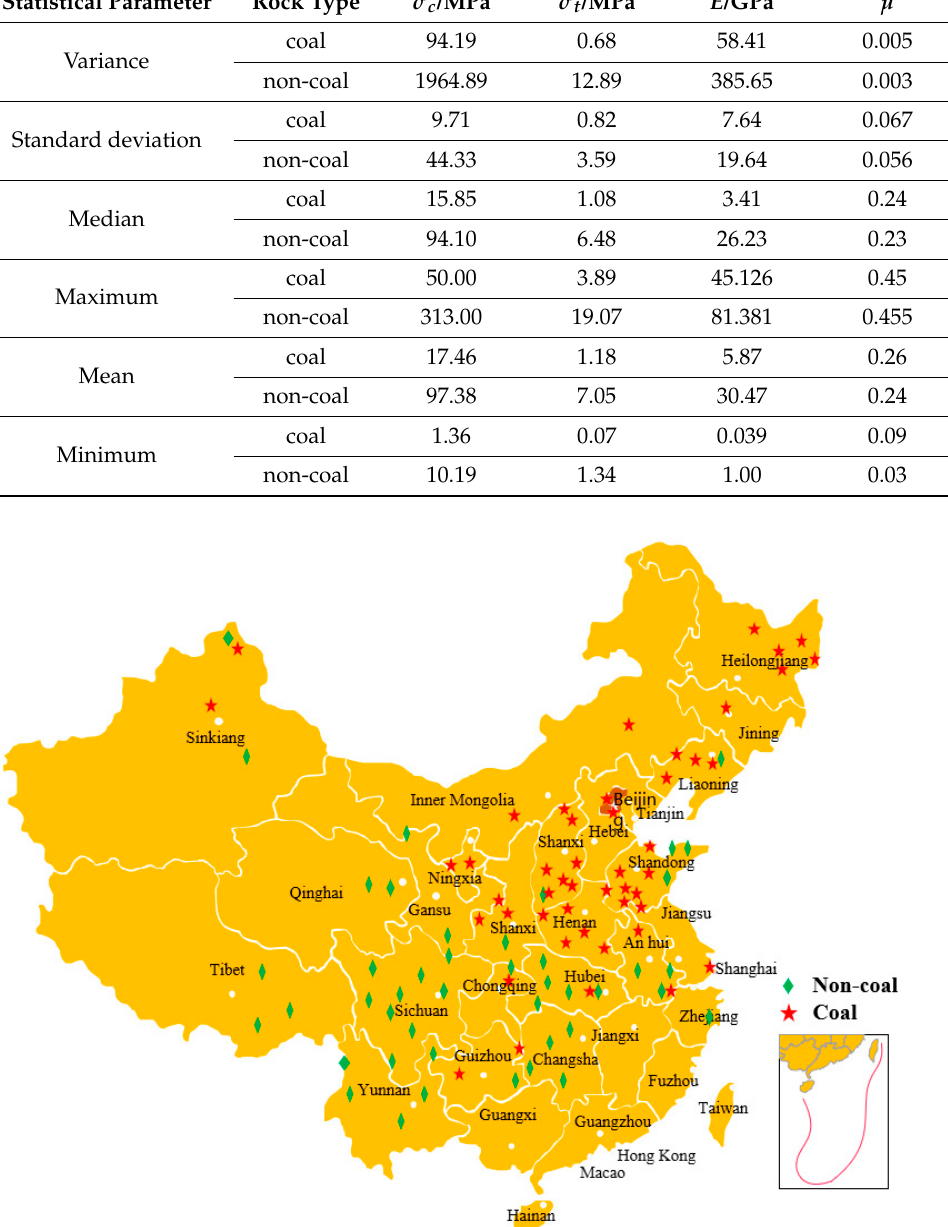
Figure 3. Statistics of basic mechanical parameters of coals and non-coal rocks: ( a ) uniaxial com- pressive strength σ c , ( b ) uniaxial tensile strength σ t , ( c ) Poisson’s ratio μ , and ( d ) elastic modulus E.